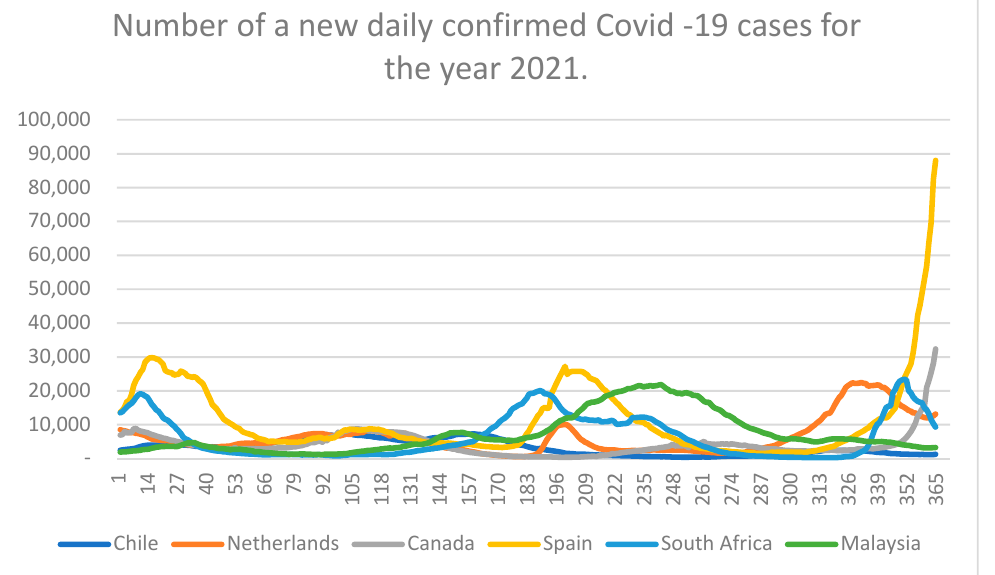
Figure 2. Trends of COVID-19 spread for six world countries in 2021 In order to display the variability of COVID-19 spread for six different countries, Ta- ble 1, with the descriptive statistics of the corresponding dataset is given next.